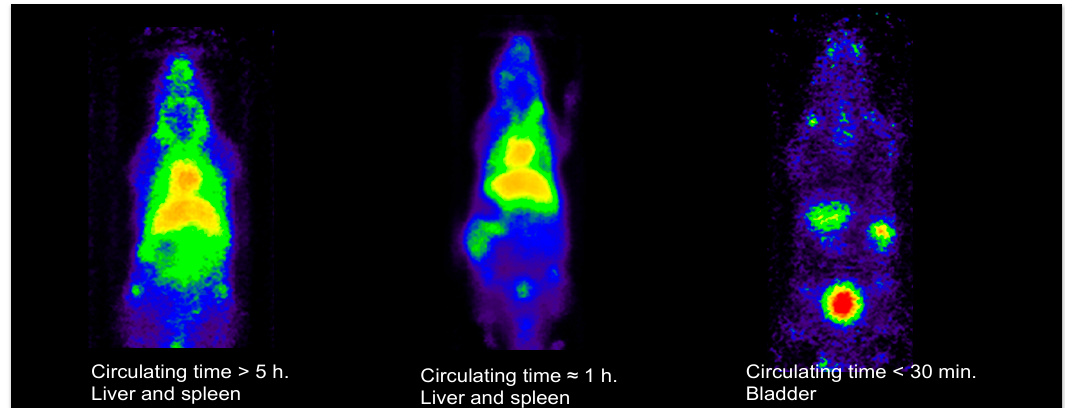
Figure 2. Differences in blood circulating time of 68 Ga core-doped iron-oxide nanoparticles (IONPs) as a function of the hydrodynamic size (unpublished results by the authors).